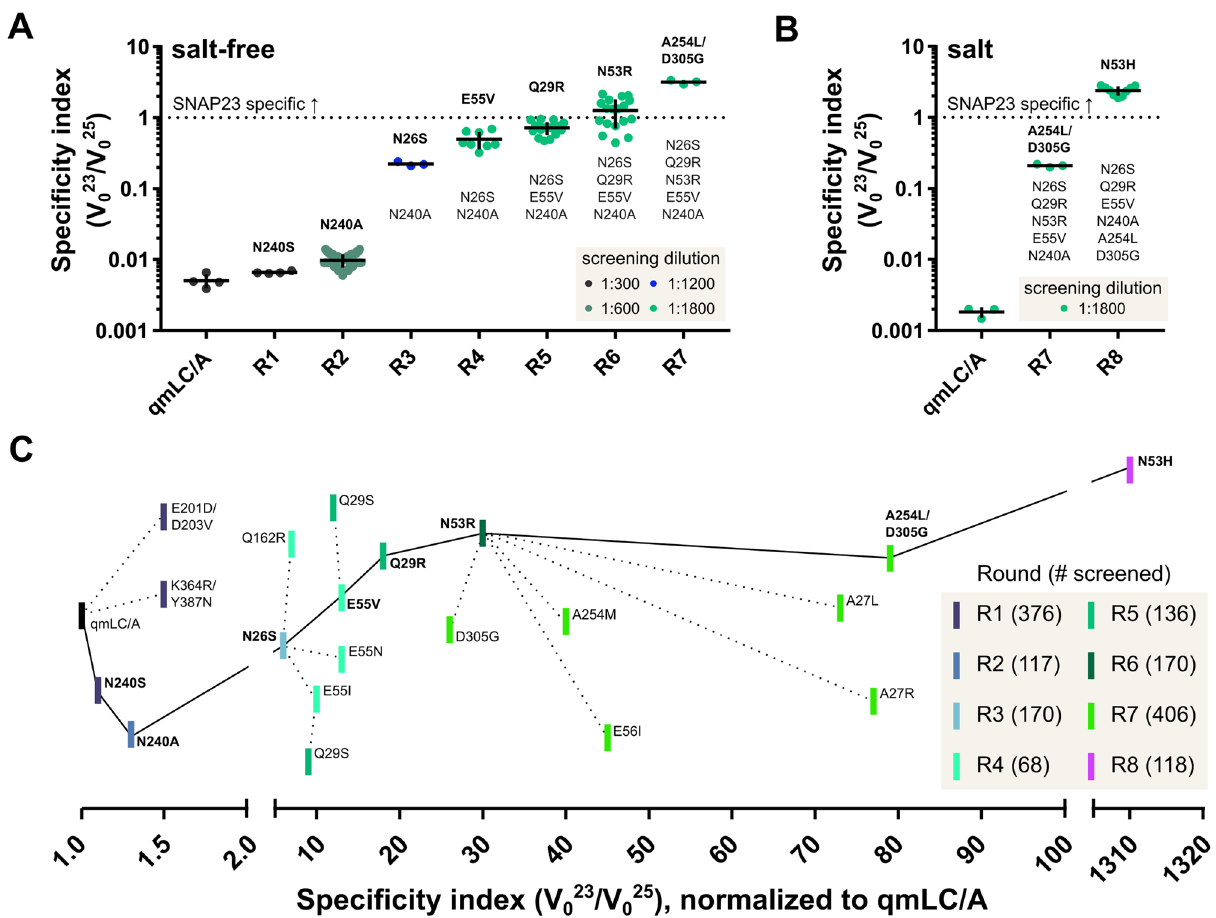
Figure 2. Directed evolution of a SNAP23-specific LC/A. ( A ) Improvement in specificity index through directed evolution in salt-free buffer. The most specific variant from each round was assayed multiple times (replicates shown). The average specificity index (horizontal bars) and standard deviation (error bars) are shown. The final dilution of cell lysates for screening is indicated by color code. ( B ) Increased specificity index achieved through directed evolution in salt buffer. ( C ) Roadmap for directed evolution showing the fold increase in specificity indices over eight rounds (R1 to R8). As shown in Fig. S1, the substrate specificity of the qmLC/A variant is sensitive to screening dilution; therefore, each point represents the variant’s average specificity normalized to the qmLC/A average specificity at the corresponding screening dilution. Advancement to the next round (solid line) weighed specificity index, protein solubility, and